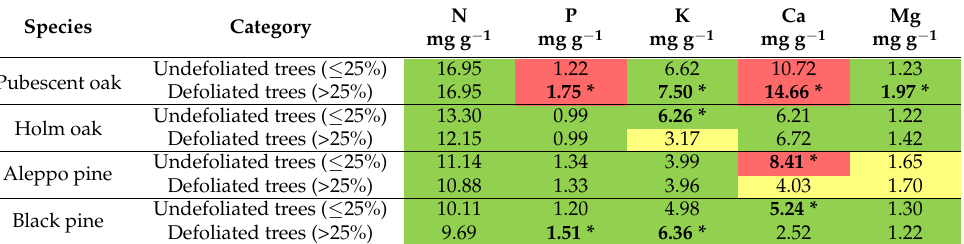
Table 1. Concentrations of nutrients (N, P, K, Ca, and Mg) in the leaves and needles of pubescent oak, holm oak, Aleppo pine and black pine for defoliated and undefoliated trees. Results are expressed as mean values ( n = 3). Values marked in bold show a statistically significant difference between defoliated and undefoliated trees for the same species according to the Student’s t -test (* p < 0.05). The colors indicate the concentrations of the elements: red—high; green—optimal; yellow—low [38].